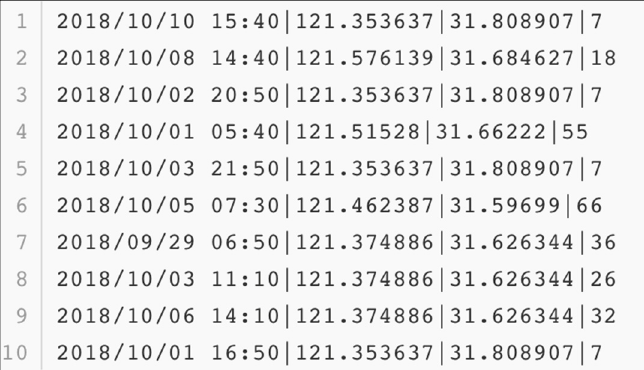
Figure 2. Raw format of mobile phone signaling data.